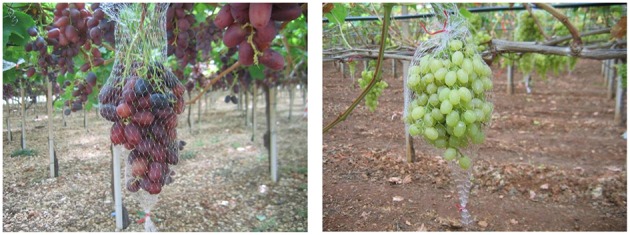
Mesh bags to prevent pre-harvest berry loss of Thompson Seedless (right) and Crimson Seedless (left) table grapes.